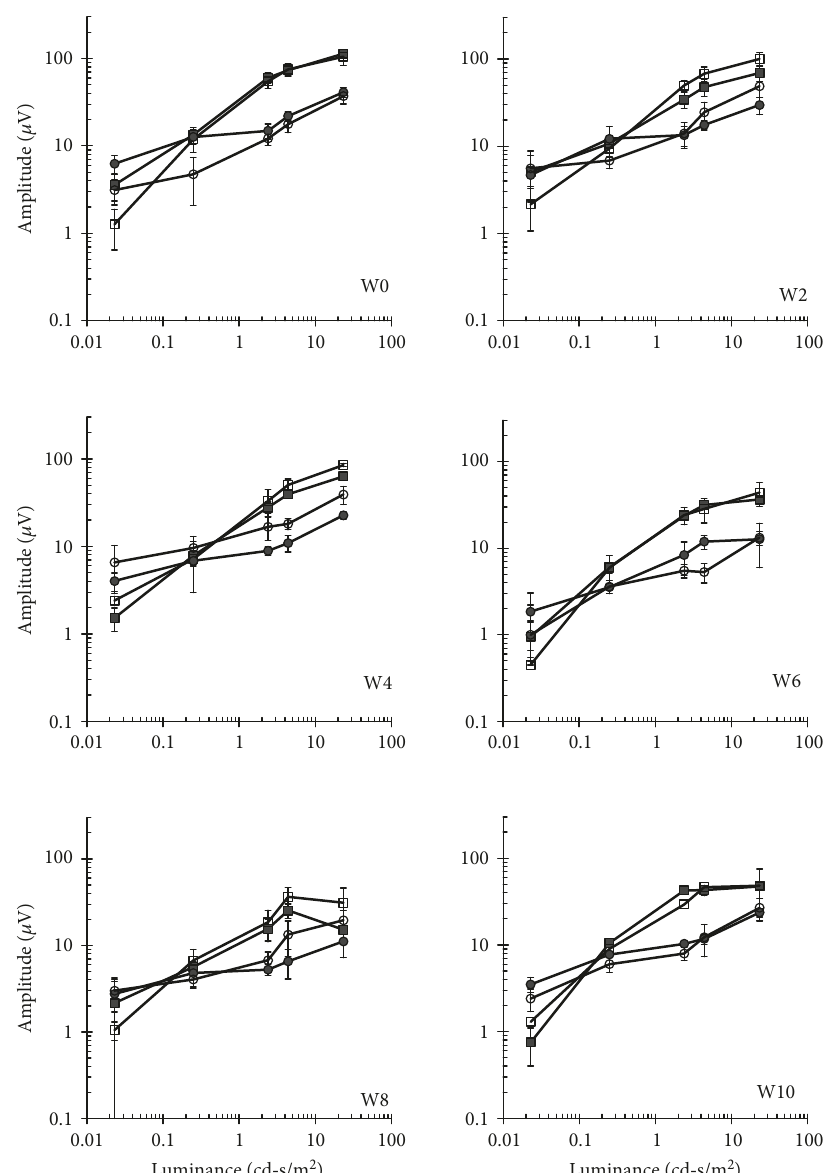
Figure 7: Long-term follow-up of photoreceptor function by a-wave ERG analysis. Mean maximal a-wave amplitude ERG responses to light fl ashes in increasing luminance levels were recorded following dark (squares) or light (circle) adaptation, in transplanted (closed) or control (open) eyes at indicated weeks (W) prior to (W0) or 2 – 10 weeks following cell transplantation. Data are presented as mean ±